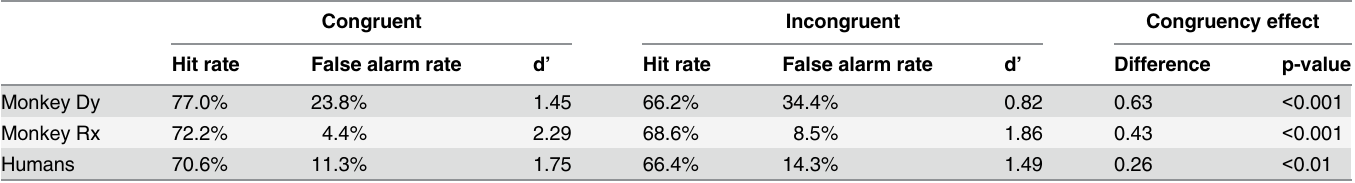
Table 2. Go-response rate (hits and false alarms) as well as sensitivity (d ’ ) in the “ real scene ” condition.